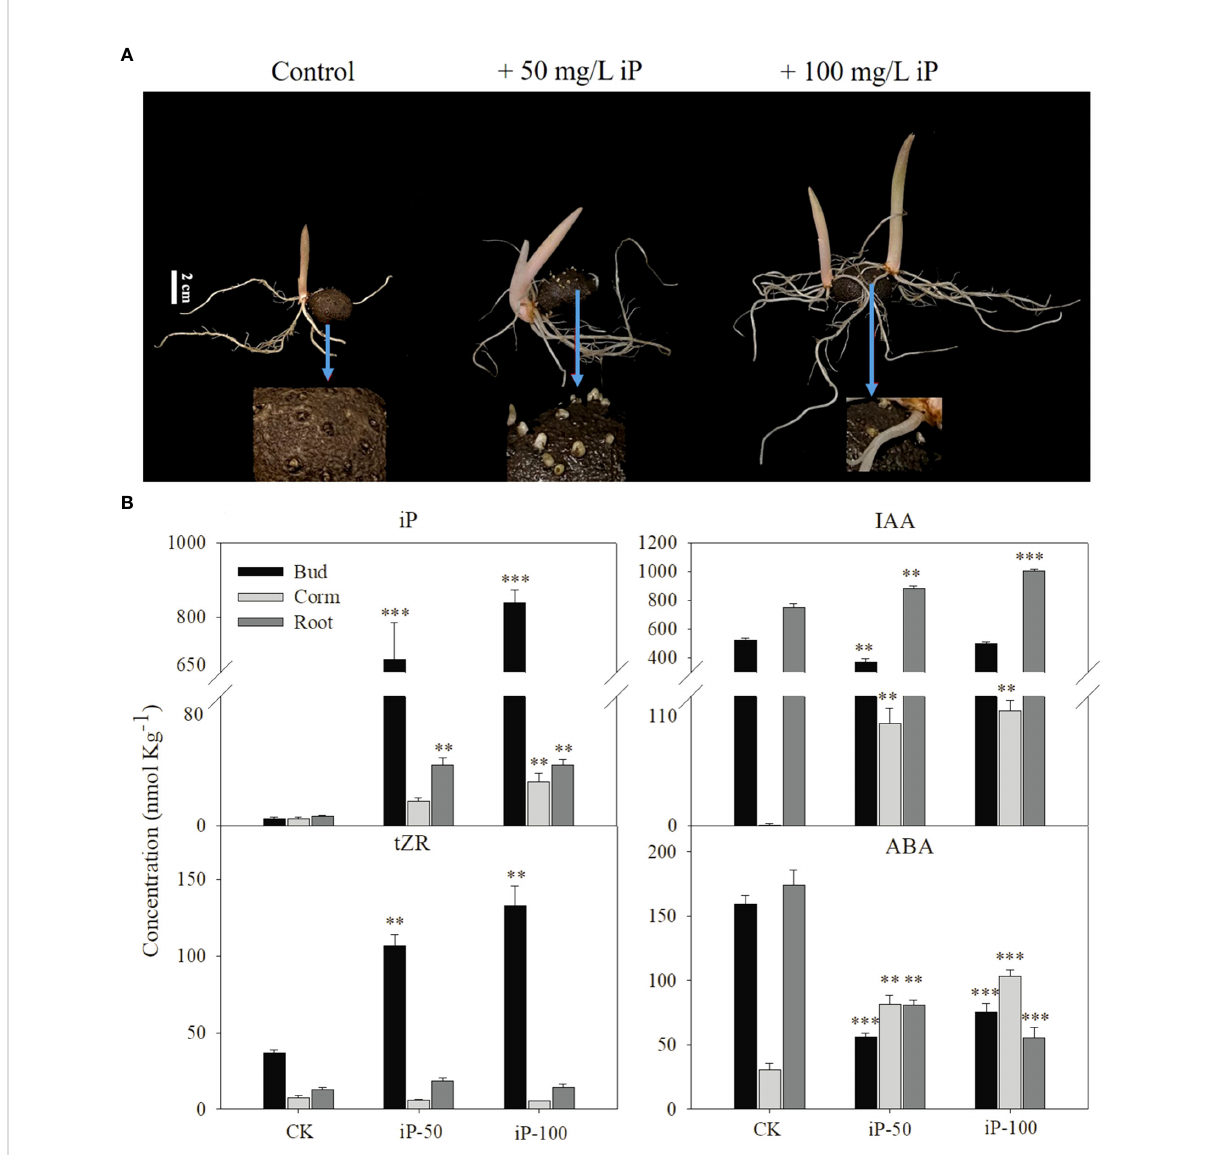
FIGURE 3 Effect of external application of iP on growth traits (A) : from leaf to right, dormant corms treated by water (control), 50 mg L -1 iP and 100 mg L -1 iP and after 30 days. White bars = 2 cm. The content of iP, tZR, IAA and ABA contents of different tissues under iP treatment (B) Error bars represent the SE (n=3), and asterisks indicate signi fi cant differences compared with the control. *: P < 0.05; **: P < 0.01; ***: P < 0.001 (based on ANOVA, followed by Tukey ’ s post-hoc tests for